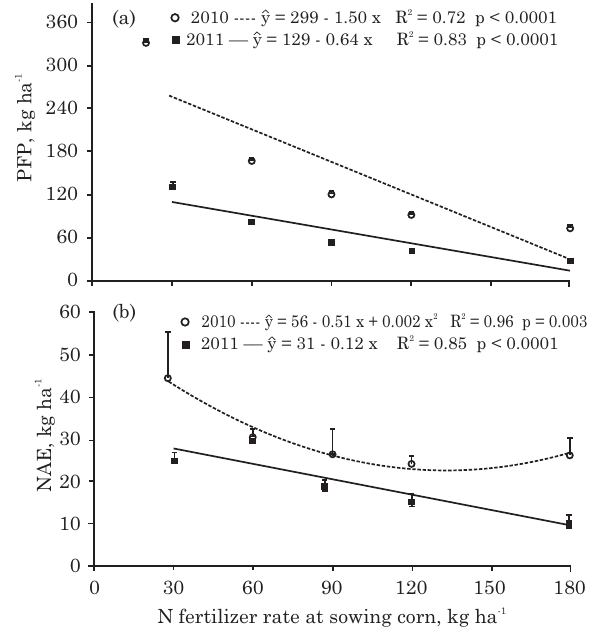
Figure 3. Partial factor productivity (PFP) (a) and agronomic N-use efficiency (ANE) (b) affected by nitrogen fertilizer rates in the 2010 and 2011 growing seasonss. The mean values of the data are shown with error bars that shown the uncertainty of the